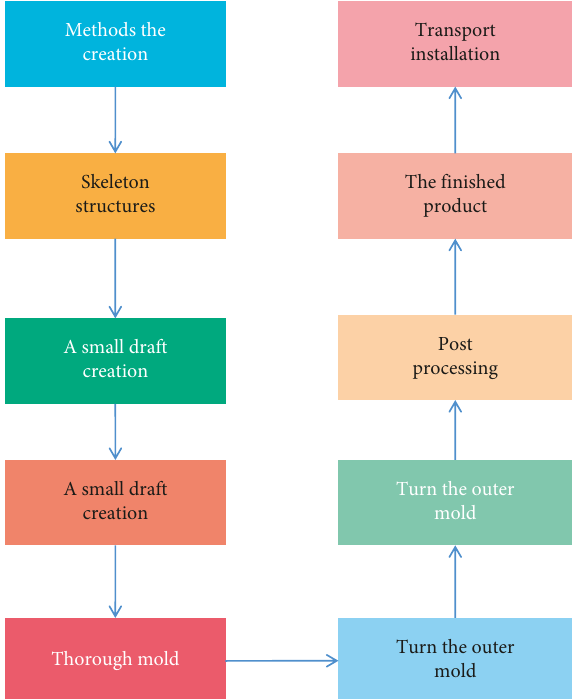
Figure 3: Flowchart of traditional sculpture production.